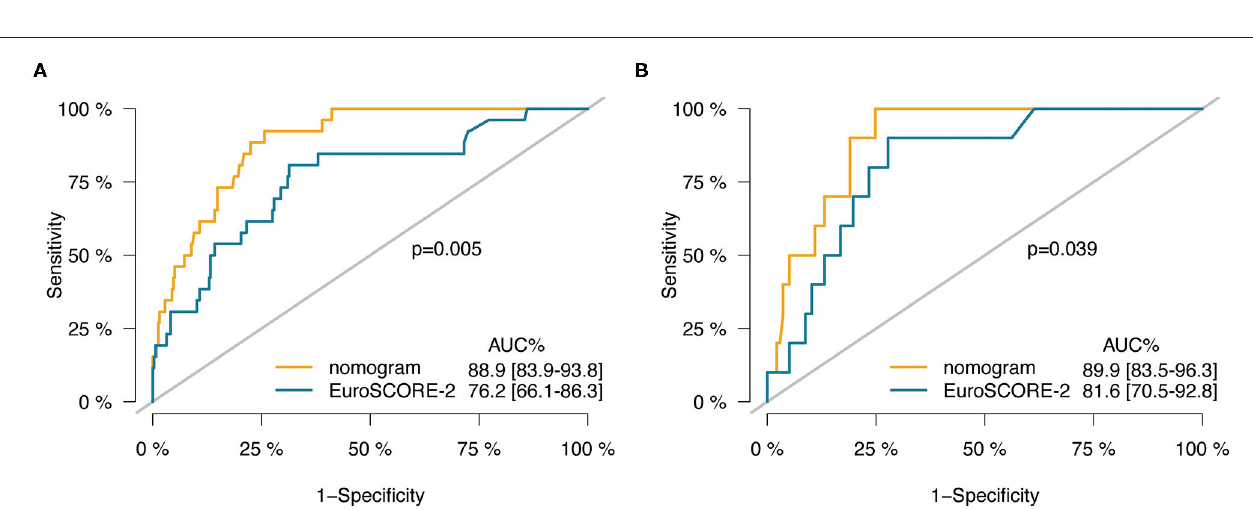
FIGURE 5 | ROC curves of the nomogram vs. the EuroSCORE-2 in training cohort (A) and validation cohort (B) .